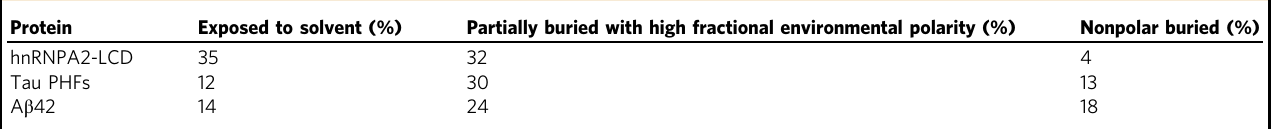
Table 6 Comparative 3D – 1D environmental pro fi les of hnRNPA2-LCD with pathogenic amyloids. Protein Exposed to solvent (%)